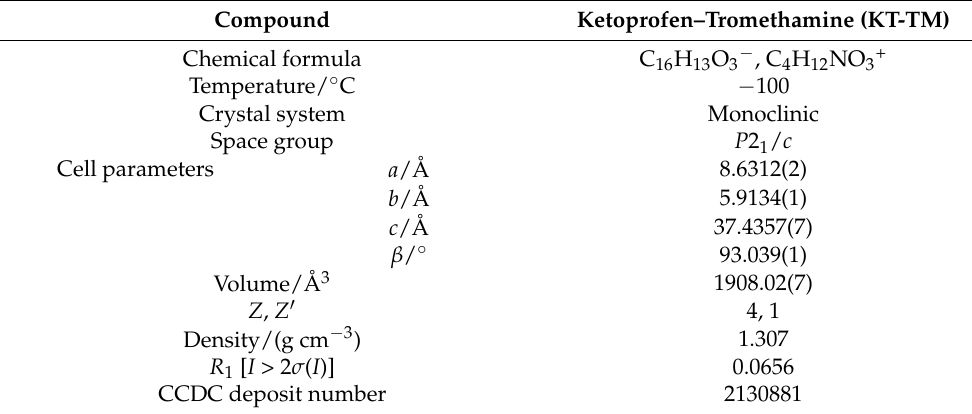
Table 1. Crystal data of KT–TM.